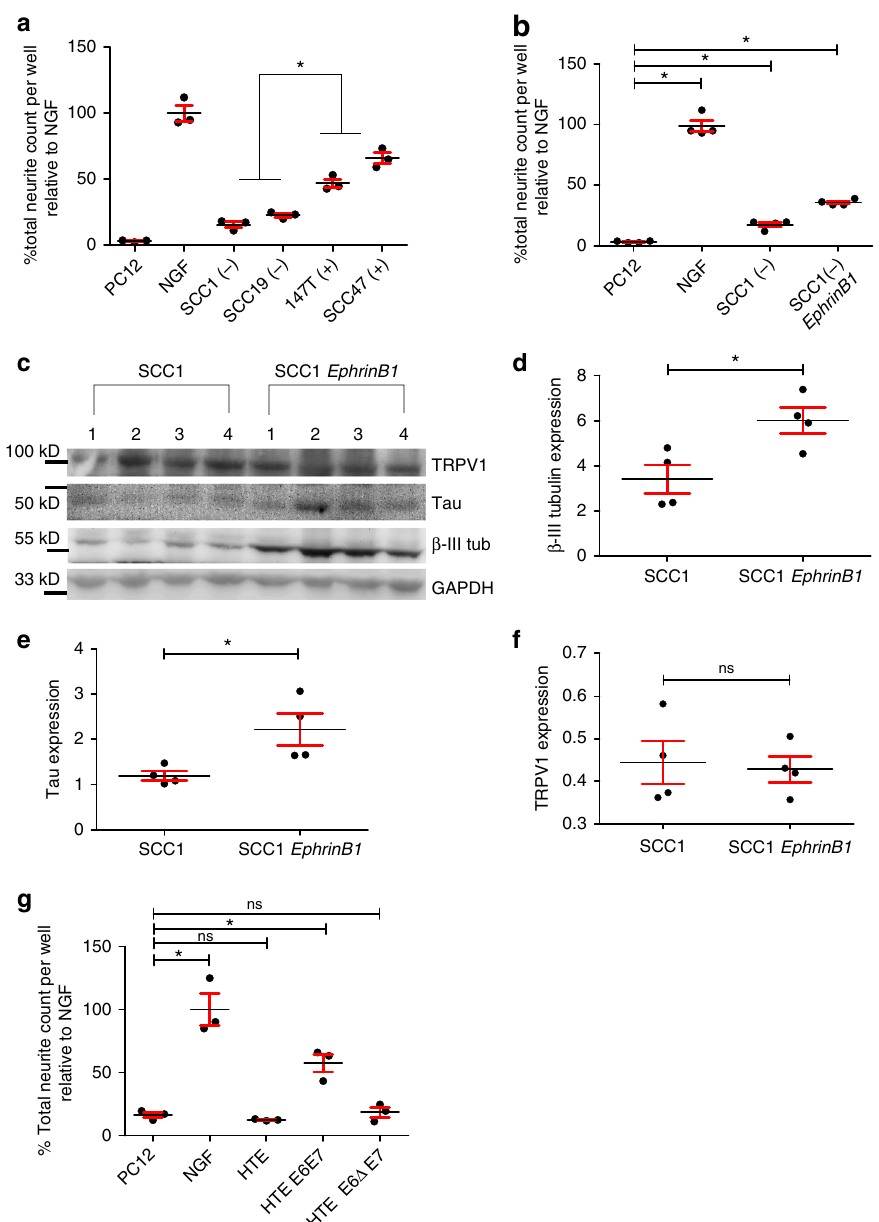
Fig. 7 HPV status and EphrinB1 contribute to neurite outgrowth. a Quanti fi ed neurite outgrowth of PC12 cells following exosome stimulation with HPV negative ( − ) or positive ( + ) human cell lines; statistical analysis by one-way ANOVA with post hoc Tukey test for differences between HPV- and + groups; * p <0.001. The variance between groups compared is similar. n = 3 technical replicates/condition; experiment repeated at least two times. Central value was the mean. Comparisons between individual groups were analyzed by one-way ANOVA with post hoc Fisher ’ s Least Signi fi cant Difference (LSD) test. All comparisons and LSD p values found in Supplementary Table 5. b Quanti fi ed neurite outgrowth of PC12 cells following exosome stimulation from HPV( − ) SCC1 parental cells or SCC1( − ) EphrinB1 over-expressing cells [SCC1( − ) EphrinB1 ]. Statistical analysis by one-way ANOVA with post hoc Fisher ’ s Least Signi fi cant Difference (LSD) test; LSD p values reported, * p <0.02. The variance between groups compared is similar. n = 4 technical replicates/condition; experiment repeated twice. Central value used was the mean. All comparison and LSD p values found in Supplementary Table 6. c Western blot analysis of whole tumor lysates from mice bearing SCC1 or SCC1 EphrinB1 tumors. Western blots repeated at least n = 4 times with technical replicates. Western blots have been cropped for clarity and conciseness. Densitometric quanti fi cation of western blot in panel c for d β -III tubulin, e Tau, and f TRPV1. Statistical analysis by unpaired, two-tailed Student ’ s t -test; * p <0.03; ns not signi fi cant. The variance between groups compared is similar. Central value was the mean. g Quanti fi ed neurite outgrowth of PC12 cells following stimulation with exosomes from HTE, human tonsil epithelia; HTE E6 Δ E7, cells expressing HPV16 E6 deleted of its PDZBM( Δ ) and E7; HTE E6E7, cells expressing HPV16 E6 and E7. Statistical analysis by one-way ANOVA with post hoc Fisher ’ s Least Signi fi cant Difference (LSD) test, LSD p values reported, * p <0.0001; ns, not signi fi cant. The variance between groups compared is similar. Central value was the mean. n = 3 replicates/condition; experiment repeated twice. All comparisons and LSD p values found in Supplementary Table 6. All error bars are standard